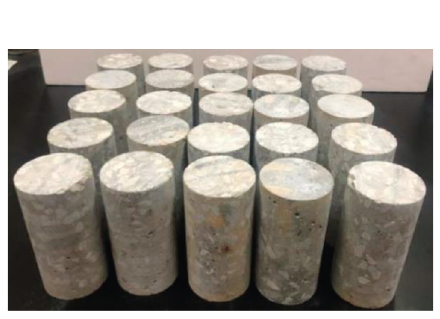
Figure 1: Concrete